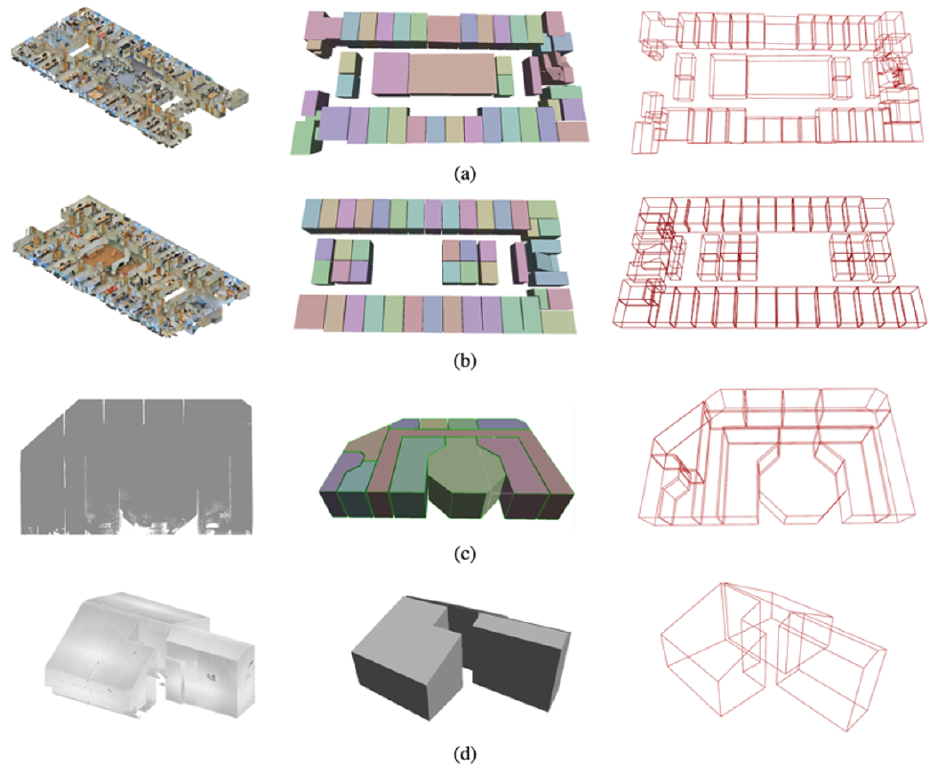
Figure 6. Reconstruction results for the four datasets ( a – d ) with the raw data ( left ), surface model ( middle ), and line framework ( right